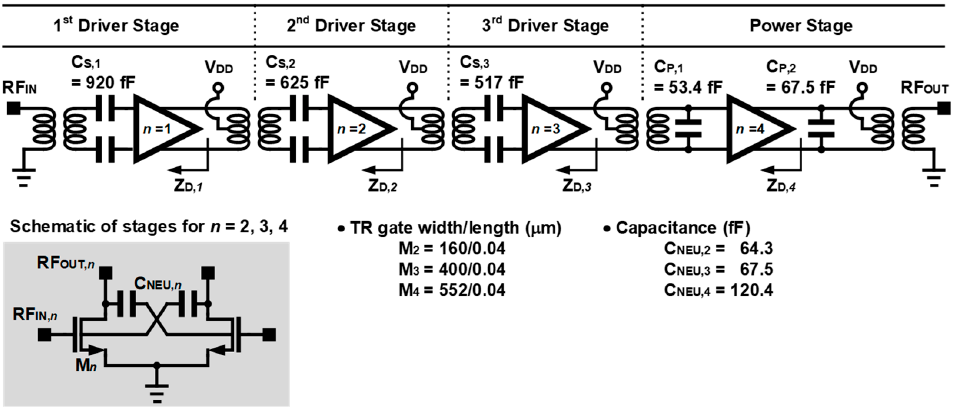
Figure 2. Schematic of the designed CMOS power amplifier.